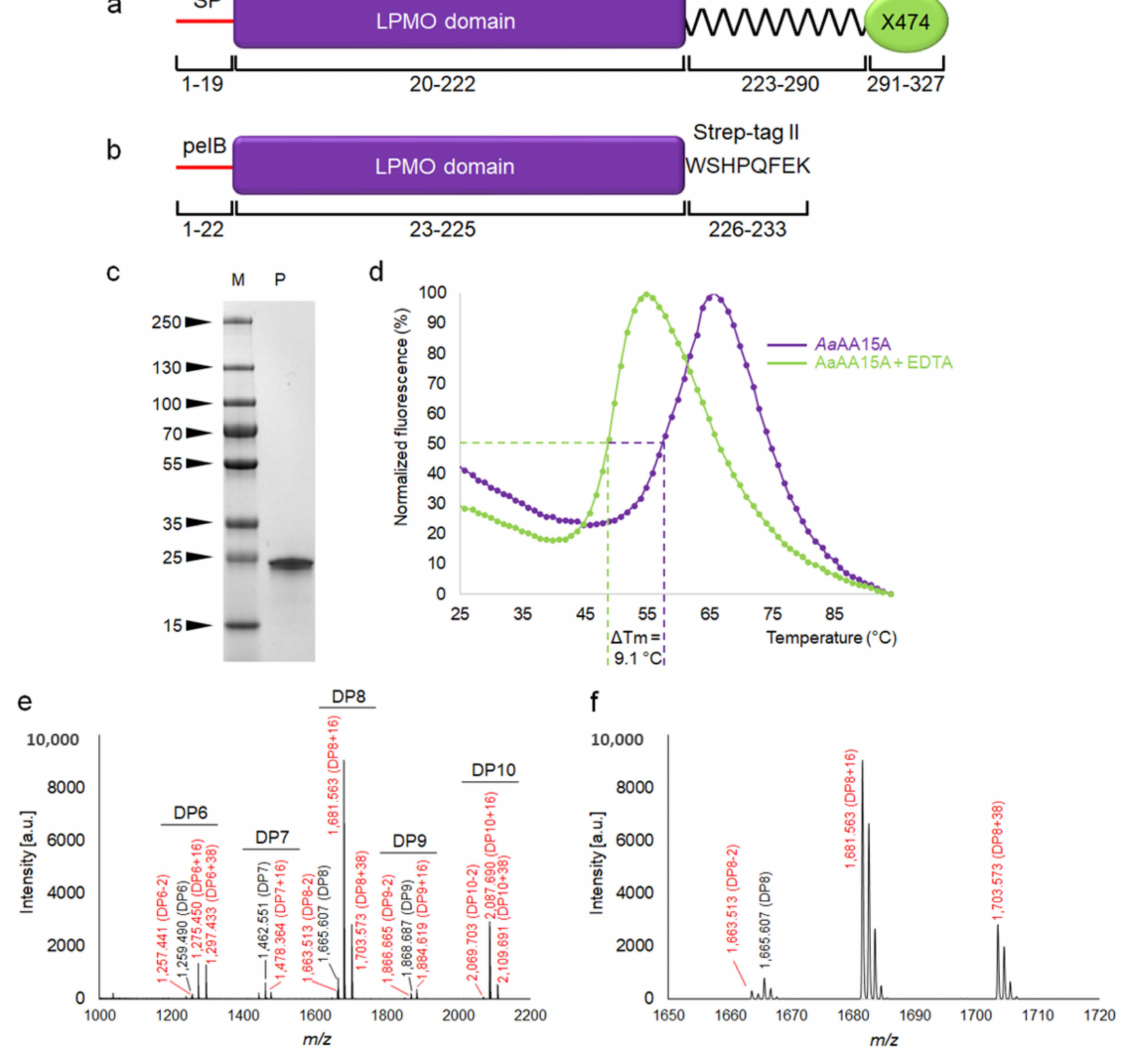
Figure 5. Domain architecture, production, stability and activity of Aa AA15A. ( a ) Architecture of the full-length Aa AA15A protein, featuring a signal peptide for secretion (SP), an AA15 LPMO domain, a 67-residue long peptide linker and an X474 domain, putatively involved in binding chitin. ( b ) Architecture of the recombinant Aa AA15A core used in this study. ( c ) SDS-PAGE of purified Aa AA15A (LPMO domain) heterologously produced in E. coli (M molecular weight markers in kDa, P purified protein). The expected molecular weight of the mature, strep-tagged protein is 22.9 kDa. The final yield from the purification of Aa AA15A was about 1 mg of protein per liter of cell culture. ( d ) Thermal shift analysis of purified Aa AA15A LPMO domain, showing the destabilizing effect of copper removal through EDTA treatment, causing a 9.1 ◦ C decrease in the melting temperature. The assay was carried out in a single repeat, with each point calculated as a moving average of three readings to filter out noise from random short-term fluctuations. The ramp rate was 1 ◦ C every 30 s. ( e ) MALDI-TOF MS spectrum of products obtained after incubation of 4 mg mL − 1 β -chitin with 2 µ M Aa AA15A and 4 mM gallic acid for 24 h, showing native and oxidized oligosaccharides. The main peaks correspond to mono- or di-sodiated adducts of C1-aldonic acids, imparting +16 or +38 m/z, respectively, relative to the mono-sodiated unoxidized form. Smaller peaks for the mono-sodiated lactone ( − 2) were also identified. Native and oxidized species are marked in black and red, respectively. ( f ) Expanded mass spectra for DP8